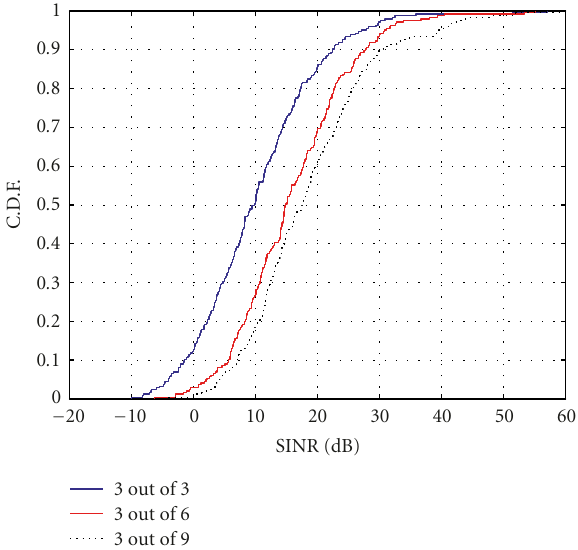
Figure 11: Cumulative distribution function of the received SINR with the di ff erent number of total relays on an urban environment with a cell radius of 500 m.